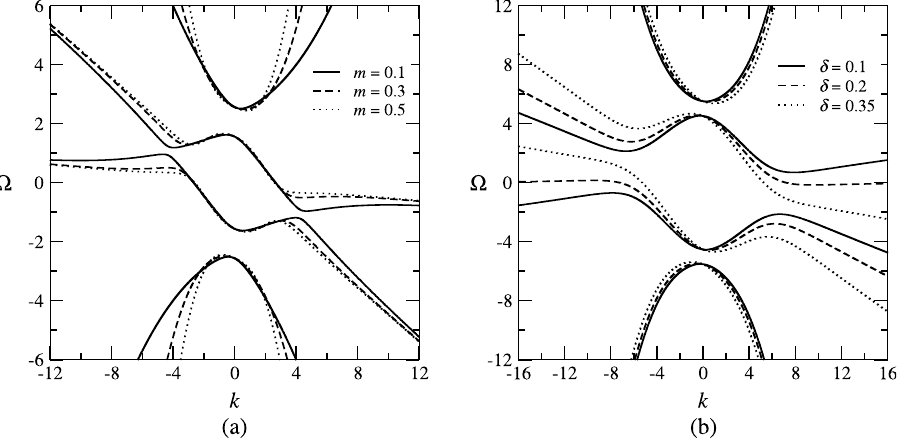
Figure 2. Dispersion diagrams for various values of m and δ . ( a ) κ = 2, δ = 0.25, and c = 0.2; ( b ) κ = 5, m = 0.3 and c =